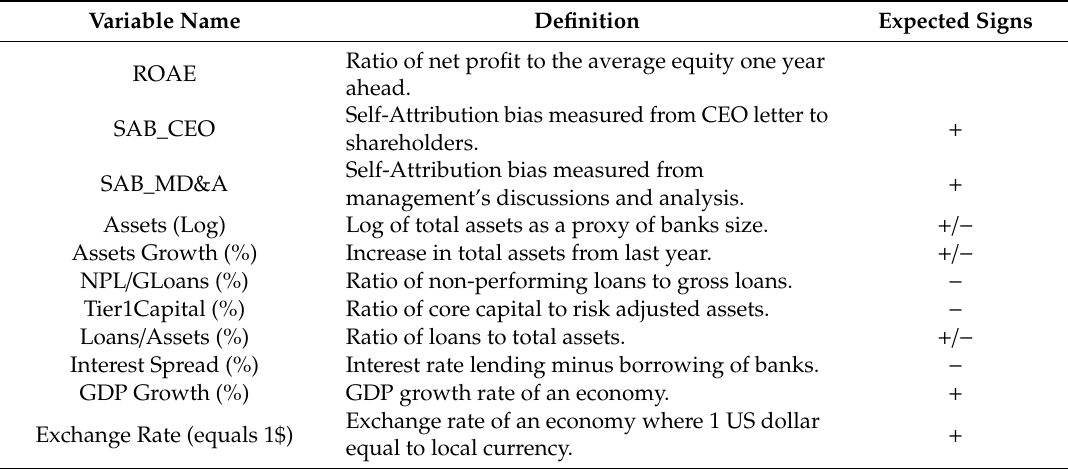
Table 1. Variables and